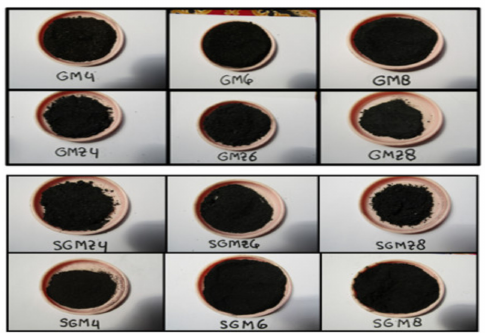
Figure 6. Activated carbon from pyrolysis of sawdust (SG) and rice husk (G) without and with ZnCl 2 (Z) at various microwave energy of 400, 600, 800 ◦